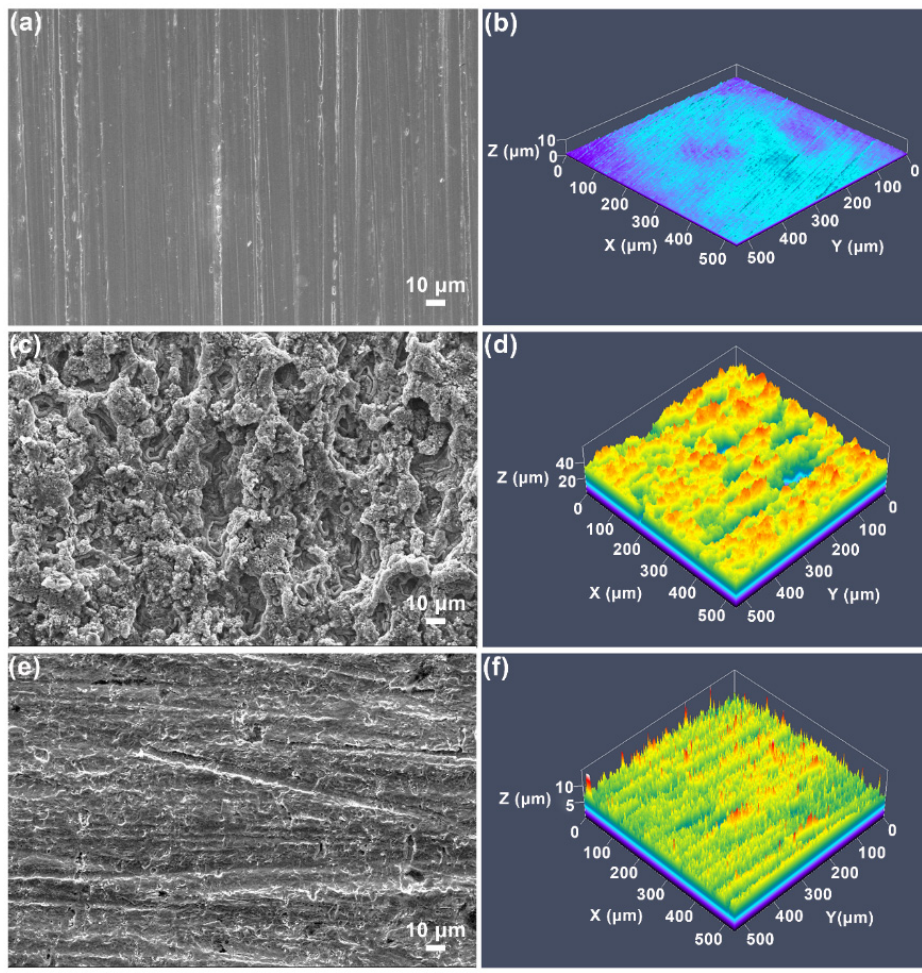
Figure 9. SEM and LSCM images of Q235 carbon steel surface before and after 60 h of exposure to 1 M HCl solution in the absence and presence of 400 ppm NCDs, ( a , b ) polished steel, ( c , d ) in blank solution, ( e , f ) in the presence of 400 ppm NCDs. Table 3. The weight loss results for steel after 12 h of exposure to 1 M HCl solution in the absence and presence of 400 ppm NCDs at various temperatures.